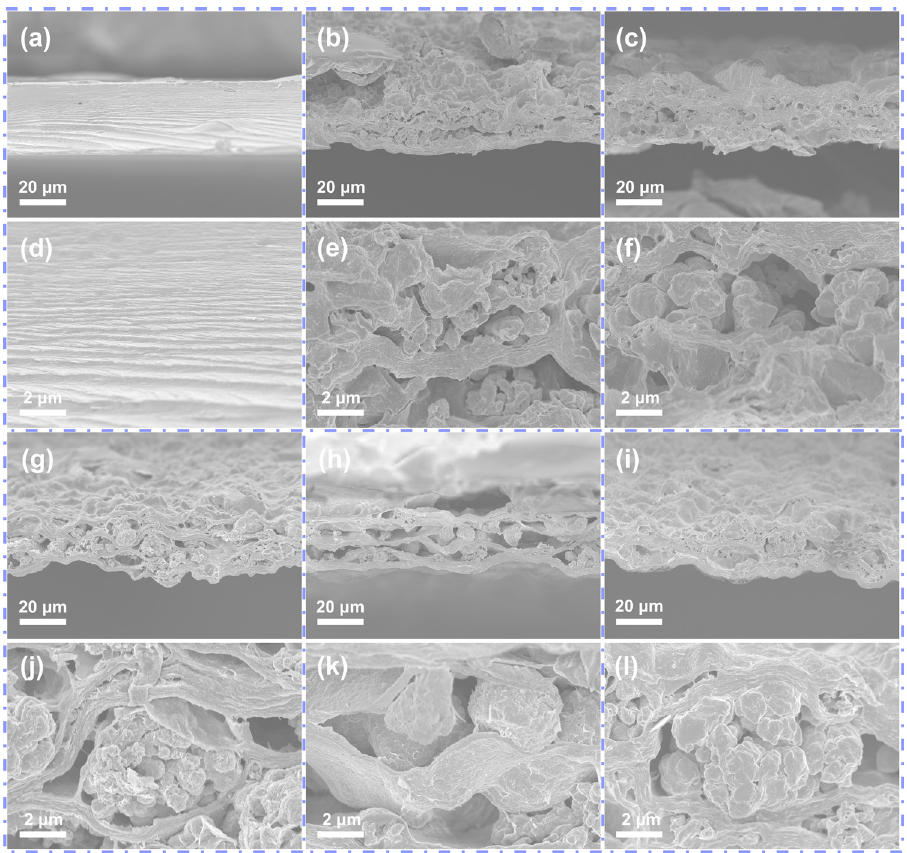
Figure 3: Sectional and their enlarged SEM images of ( a and d ) pure CNF fi lm and MXene/Cu/CNF fi lms with di ff erent copper powder diameters of ( b and e ) 0.1, ( c and f ) 0.5, ( g and j ) 1, ( h and k ) 2 and ( i and l ) 5 μ m,